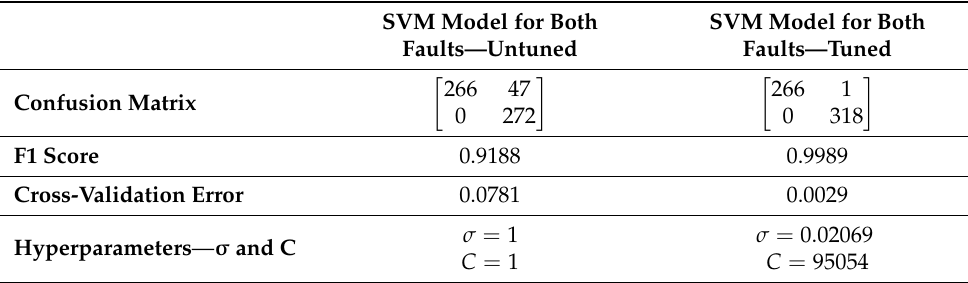
Table 7. SVM results for model trained for both types of faults—tuned and untuned. SVM Model for Both SVM Model for